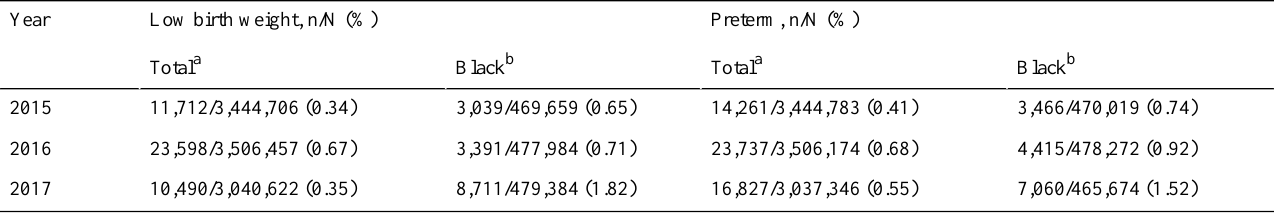
Table 6. Differences in the absolute numbers and proportions of low birth weight and preterm births between mothers living in states in the highest tertile for negative racial sentiment and mothers living in states in the lowest